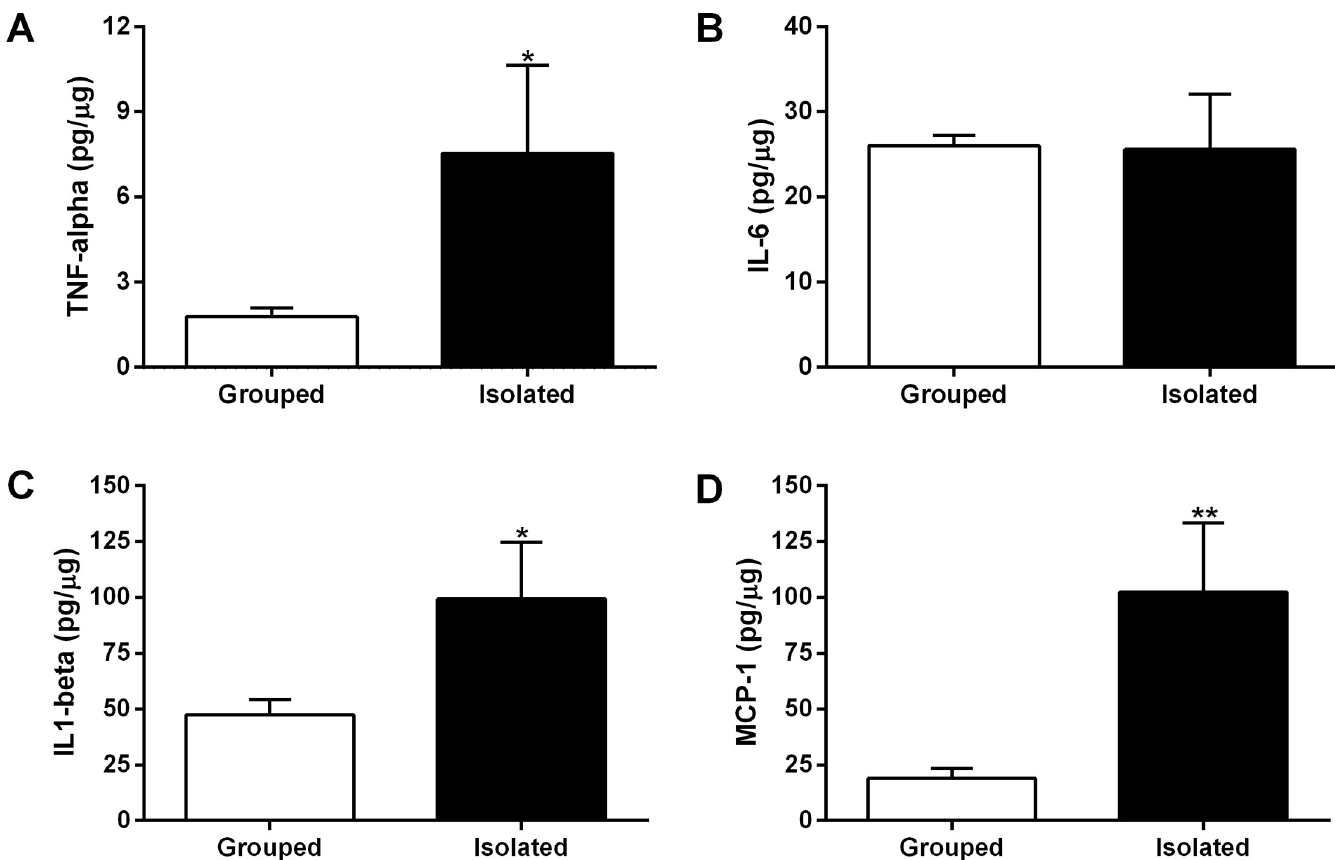
Fig 3. Levels of inflammatory mediators in the OSCC microenvironment. TNF-alpha (A) , IL-6 (B) , IL1-beta (C) and MCP-1 levels (D) . Eight tumor samples from each group were randomly chosen to perform the analyzes. Student’s test T displayed that the levels of inflammatory mediators, except the IL-6 levels, were increased in the tumor microenvironment from isolated animals. � p < 0.05 and �� p < 0.001 indicate a statistically significant difference. Bar graphs represent the mean ± standard error of the mean (SEM).